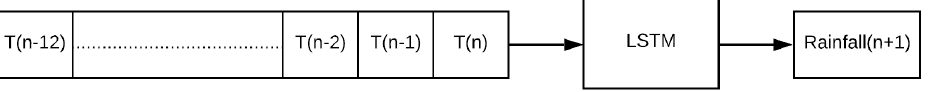
Figure 5. Many (12) to One LSTM utilized in the experiment. Each sample of data contains 12 time-steps of previous data. We used 12 months of previous data to predict the rainfall of the next month (n +